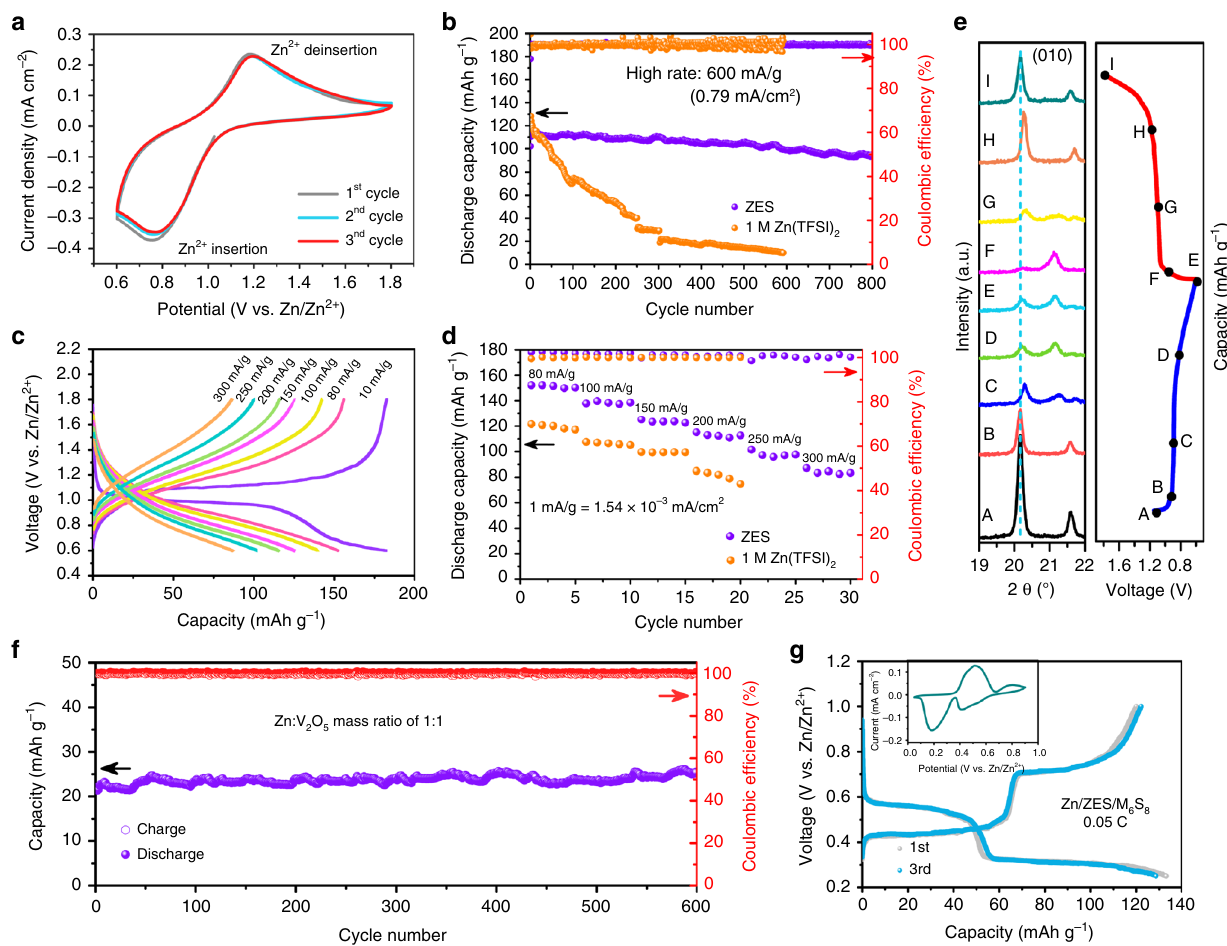
Fig. 6 Electrochemical properties of ZIBs. a Typical CV curves of the Zn/V 2 O 5 cell using ZES at a scan rate of 0.5 mV s − 1 . b Charge/discharge cycling performance and CE of the Zn/V 2 O 5 cells with ZES (after activation under 1 A g − 1 ) and 1 M Zn(TFSI) 2 electrolytes at 600 mA g − 1 (0.79 mA cm − 2 ) . c Charge/discharge curves at various current densities in ZES. d Rate performance of ZES and 1 M Zn(TFSI) 2 electrolytes. e XRD patterns of the V 2 O 5 cathode at different voltage states of the fi rst cycle in ZES (10 mA g − 1 ). f Long-term cycling performance of the Zn//ZES//V 2 O 5 cell with the Zn:V 2 O 5 mass ratio of 1:1 at 8.43 mA cm − 2 (after activation under same rate; the capacity is calculated based on the total mass of cathode and anode). g Typical galvanostatic charge/discharge pro fi les and CV curves (inset) of the Zn/Mo 6 S 8 cell with ZES electrolyte. The current densities are calculated on the activated materials of